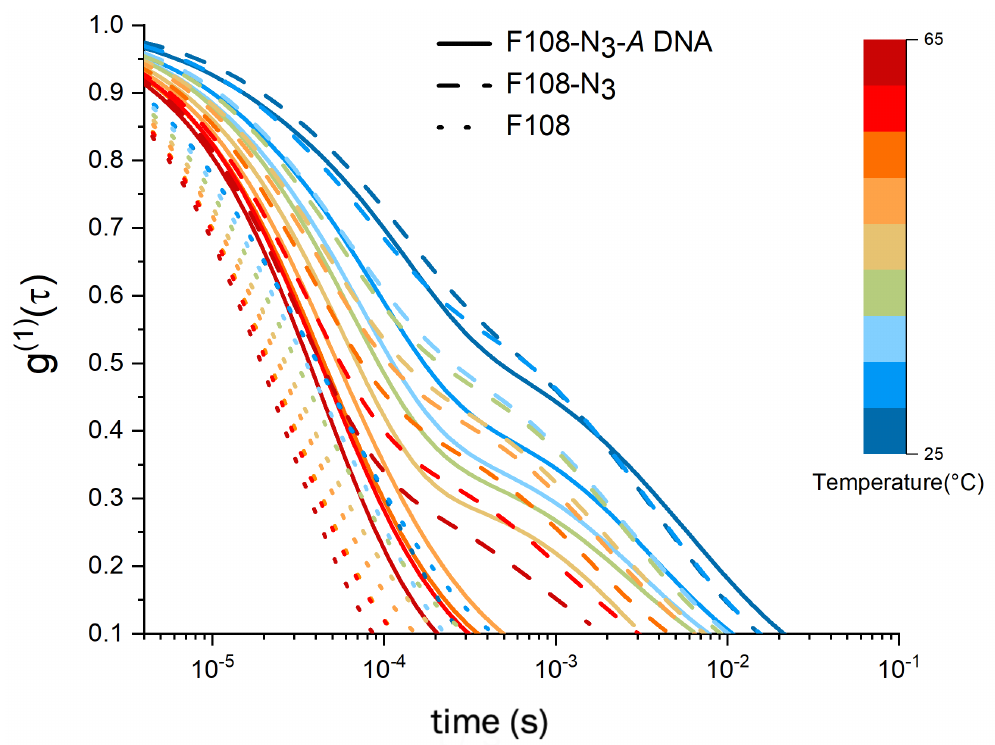
Figure 4. Comparison of g ( 1 ) ( τ ) spectra of a 8.25 %w/v F108 with a F108-N 3 and a F108-N 3 -DNA (10:1) solution containing only A -DNA such that no hybridisation can take place. All solutions were prepared in 100mM NaCl and measured in DLS as function of